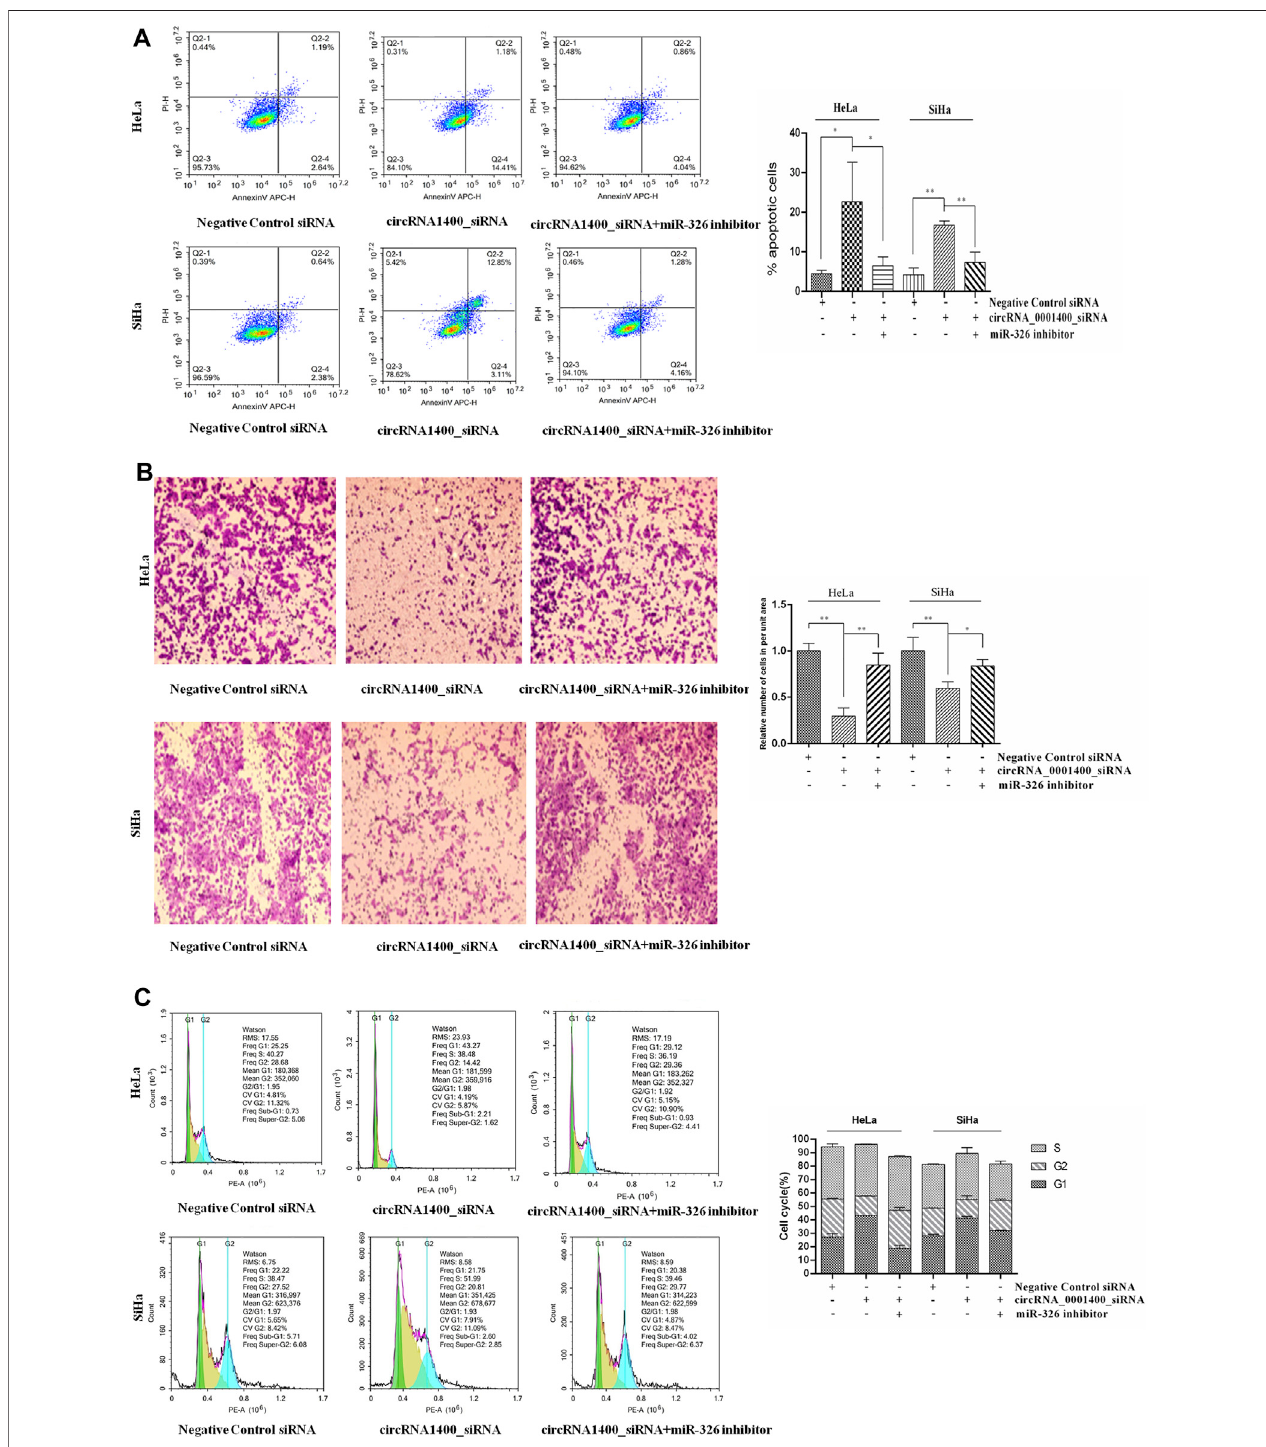
FIGURE4| Hsa_circRNA_0001400targetingmiR-326rescueexperiment. (A) Apoptosisrecoverytest; (B) cellmigrationrecoverytest; (C) cellcyclerecoverytest; and (D) Akt and Phospho-Akt (Ser473) expression. (E) The effect of miR-326 inhibitor rescue of hsa_circRNA_0001400_siRNA on hsa_circRNA_0001400. (F) The effect of miR-326 inhibitor rescue of hsa_circRNA_0001400_siRNA on miR-326. Data are expressed as mean ± standard deviation, n (cid:2) 3, * p < 0.05 and * * p < 0.01 vs. control group.